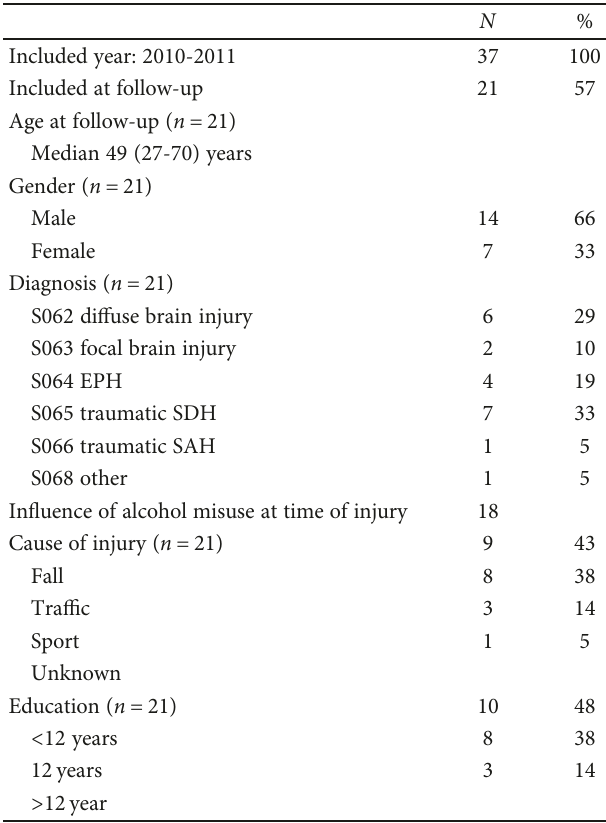
Table 1: Demographic injury characteristics for persons with severe traumatic brain injury in northern Sweden (approximately 900,000